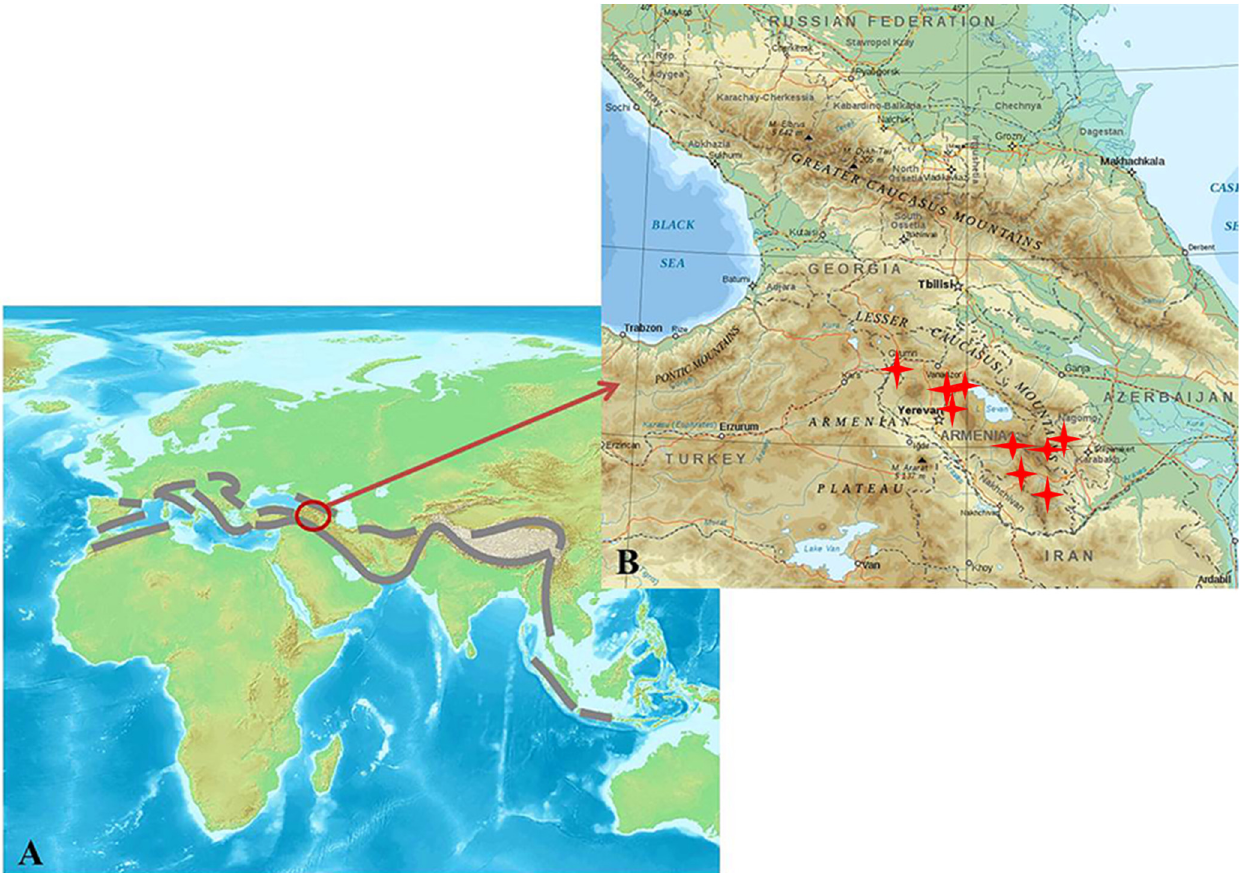
Figure 1. Alpide (Alpine–Himalayan) orogenic belt (marked by brown intermittent lines) ( A ) and the Greater and Lesser Caucasus Mountains ( B ). The locations of the studied geothermal springs are indicated by red four-point stars. The maps were sourced from: https://en.wikipedia.org/wiki/Alpide_belt and https://en.wikipedia.org/wiki/Caucasus (accessed on 2 March 2008 and 23 July 2016, respectively).